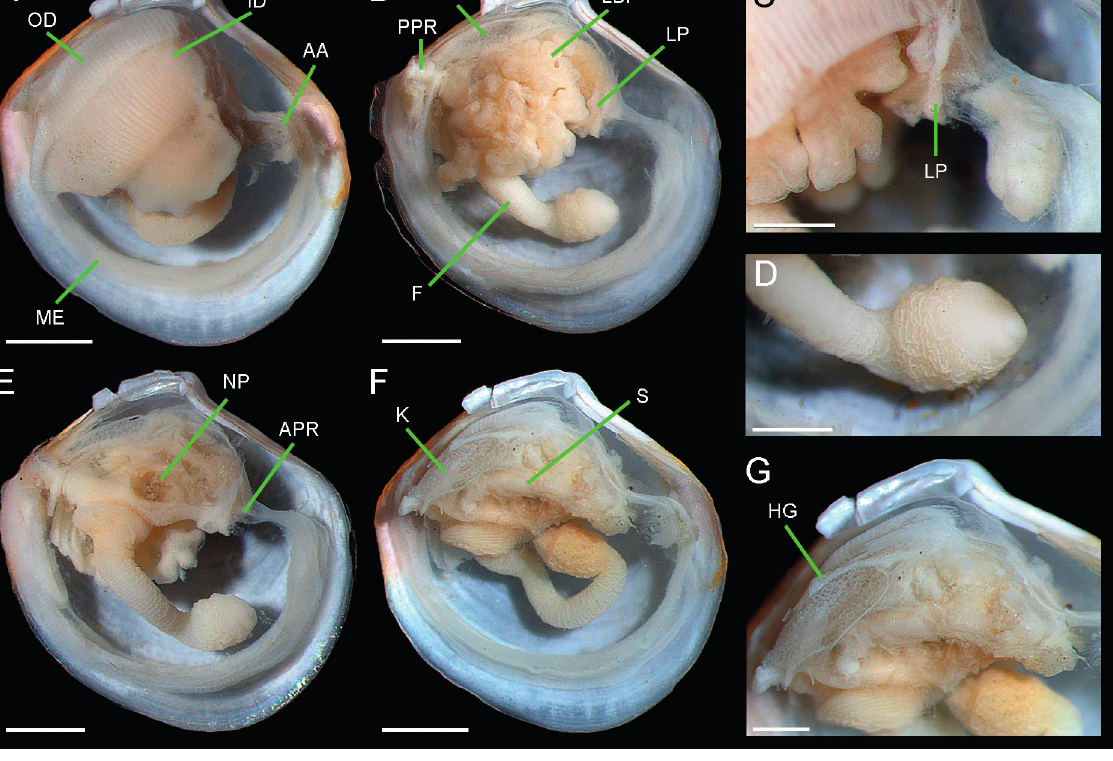
Fig. 11. Parathyasira pauli sp. nov. (IORAS OBF collection Cat. BIV00041). A . Gross anatomy after removal of right valve and mantle, shell length 4.3 mm. B . Gross anatomy after removal of right valve, mantle, ctenidium, and anterior adductor muscle, shell length 4.3 mm. C . Labial palps. D . Bulbous portion of foot. E . Gross anatomy after further removal of right lateral body pouch. F–G . Digestive system. Abbreviations: see Material and methods. Scale bars: A–B, E–F = 1 mm; C–D, G = 500